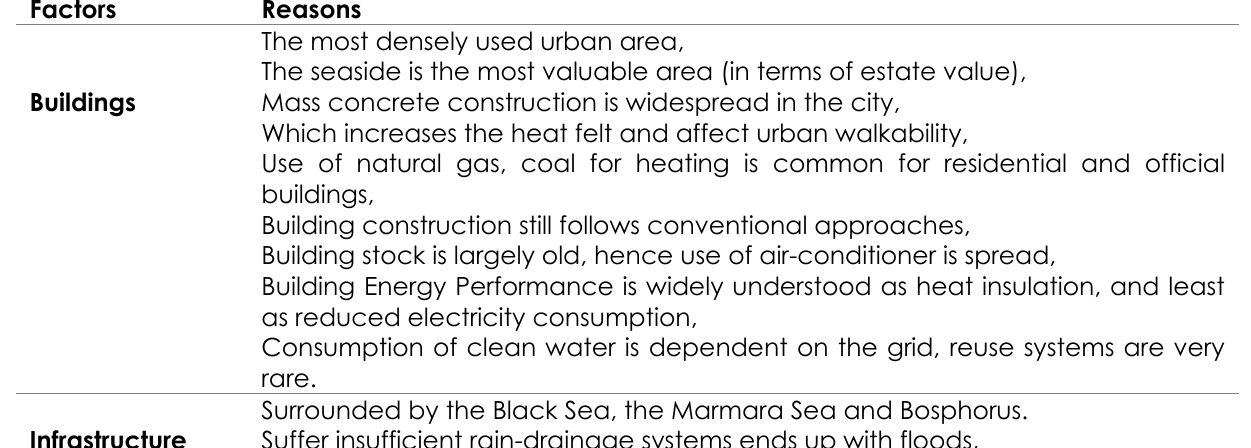
Table 2. The of reasons to have floods frequently in Istanbul, the mega-city of Turkey.